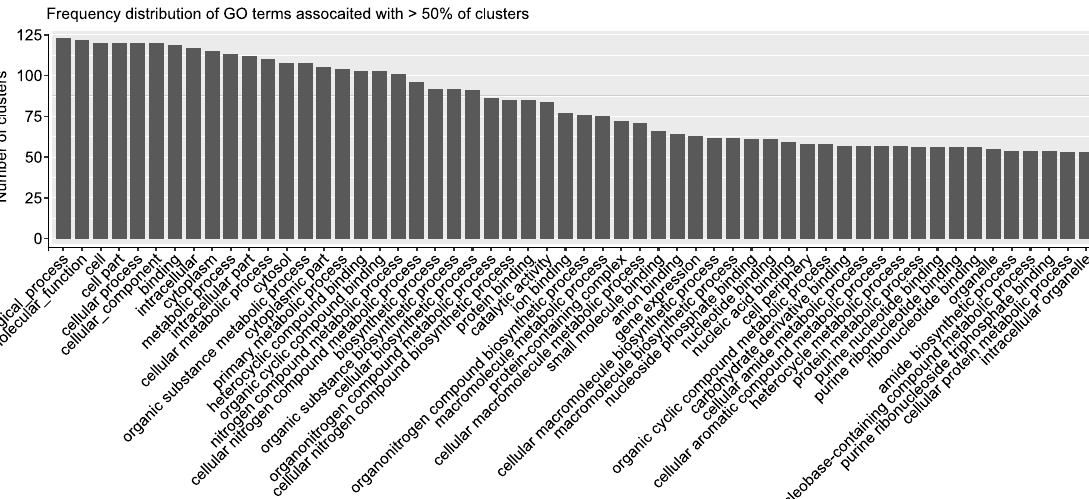
orthologueclustersthatwereconservedacrossall20genomes. B Frequencyforall 1882 GO terms associated with the 125 conserved clusters (top barplot). Those associated with >50% of these clusters (outlined in red) are highlighted in the enlarged plot (bottom barplot) with their functional annotations provided. A complete list of all GO and KEGG metabolic pathway terms associated with the 125 core clusters is provided in Supplementary Data